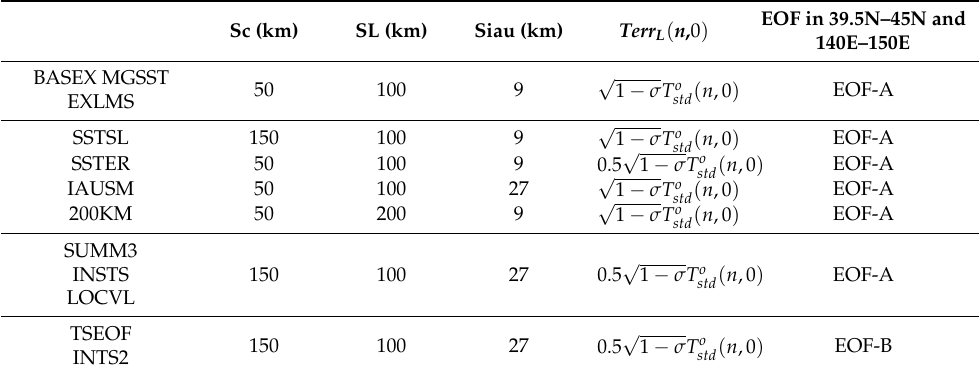
mean model data T f ( S f ) because the smoothing of the tidal fluctuations simulated by the model was required for the stable calculation [9]. As represented by the angle brackets in the procedure Equation (A8), the IAU forcing terms were further smoothed spatially with a Gaussian smoothing scale of Siau = 9 km for preserving the small-scale variability represented by the model and for mitigating the gap of the IAU forcing between the IAU target region and other no IAU regions where the forcing term was zero. Note that the IAU forcing terms were applied in only the offshore region with a bottom depth greater than 50 m. Table A1. Parameters used in the sensitivity experiments. Sc (km) SL (km) Siau (km)